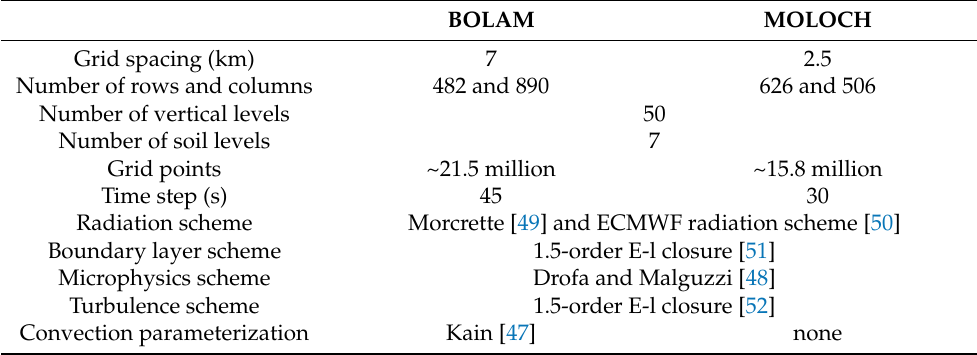
Table 1. Setup of the key characteristics of the BOLAM and MOLOCH